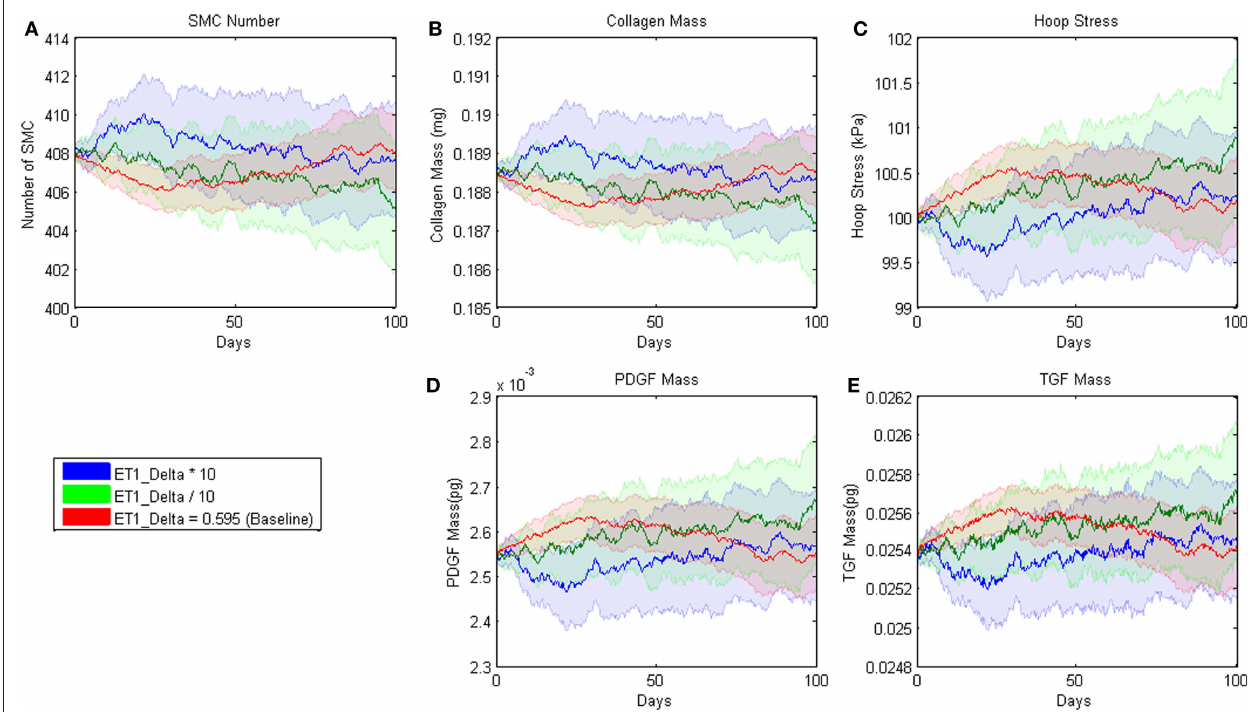
Figure 2 | Parameter sensitivity analysis for the parameter δ in the rule for eT-1 production (cf. Table 3.1). This rule states that the production of ET-1 by ECs depends on wall shear stress in a sigmoid fashion. Each solid line represents the mean value based on 100 replications of the ABM. Blue indicates